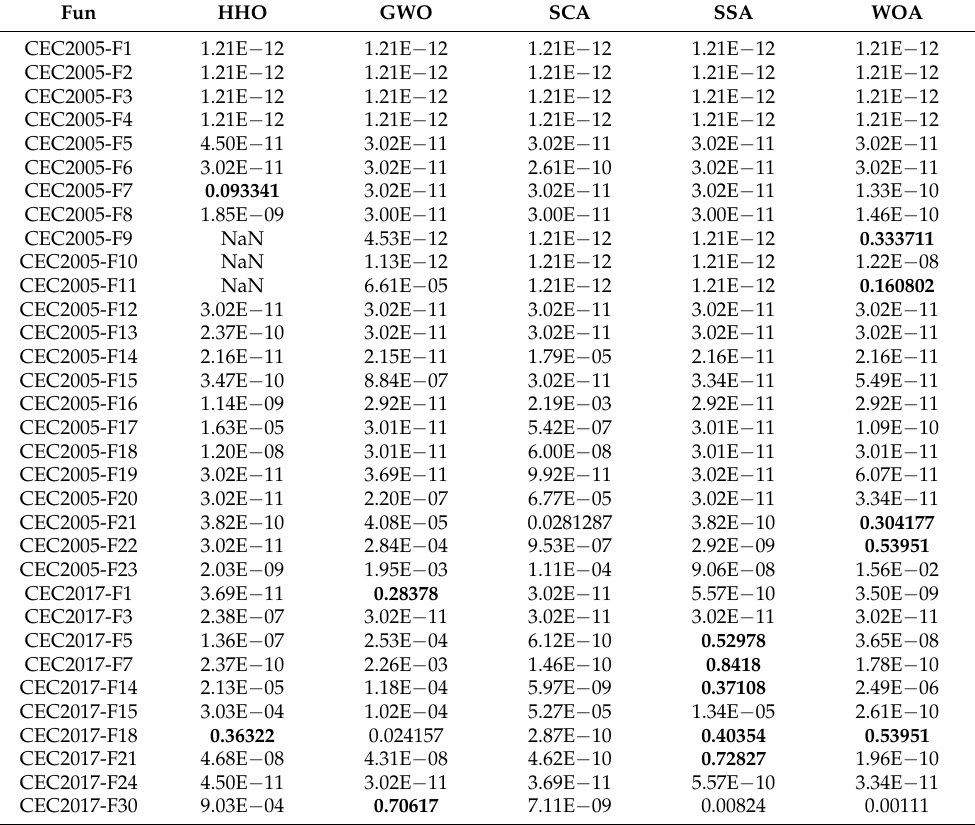
Table 6. Results of Wilcoxon rank sum test for different algorithms.